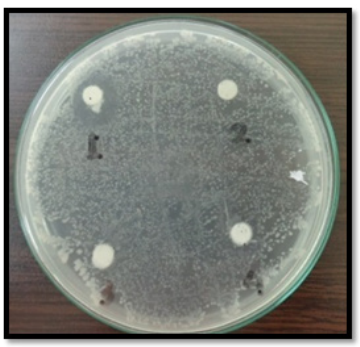
Fig. 1. Observation of endophytic bacterial fermentation fluid inhibitory zone towards Streptococcus mutans test Table 1. Macroscopic and microscopic results of antibiotic-producing endophytic bacteria isolate from Citrus aurantifolia leaves